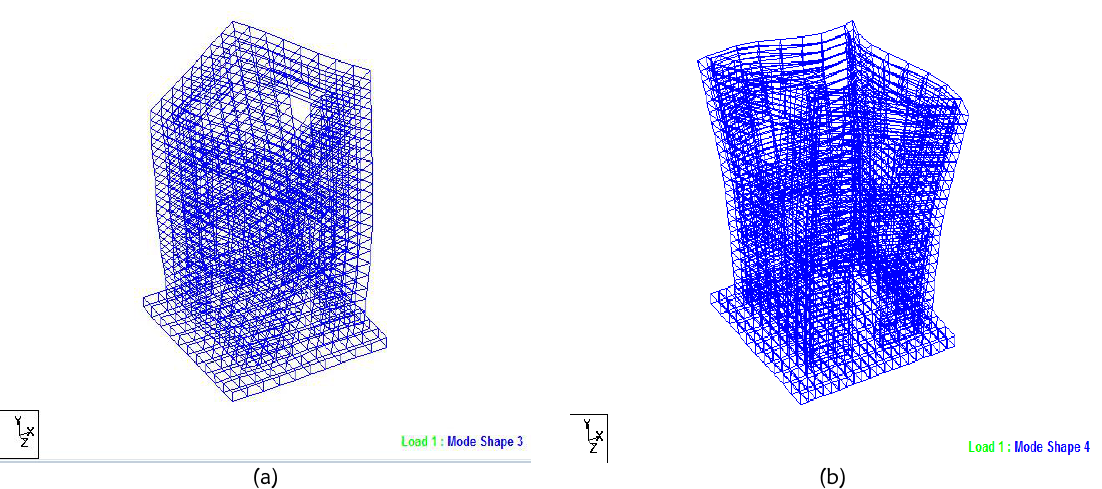
Figure 7 . First torsion mode shape model of ( a ) unreinforced ( Mode 3, 4 . 021 Hz ) double story and ( b ) reinforced double story ( Mode 4, 7 . 11 Hz )